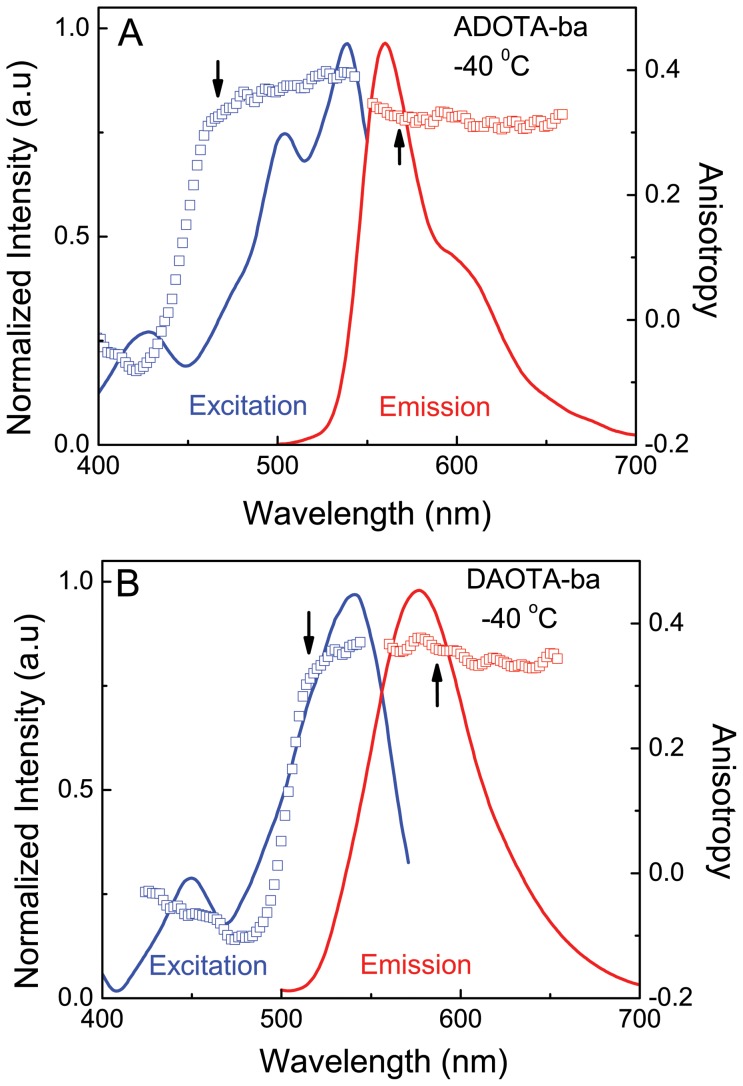
Excitation and emission intensity and anisotropy spectra in 95% glycerol at -40°C.(A) ADOTA-ba (B) DAOTA-ba. The arrows indicate wavelengths of excitation and emission.